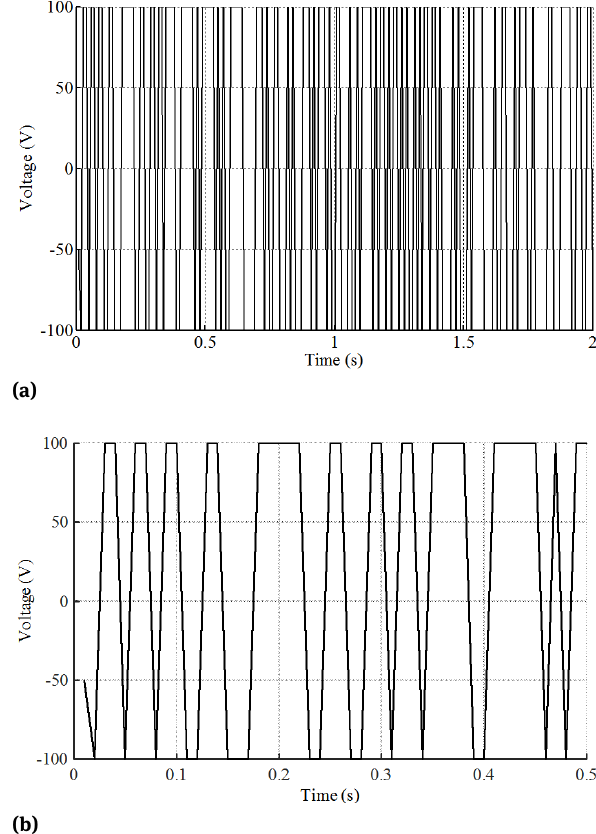
Figure 3: The applied voltage (a) full range (b) Detail